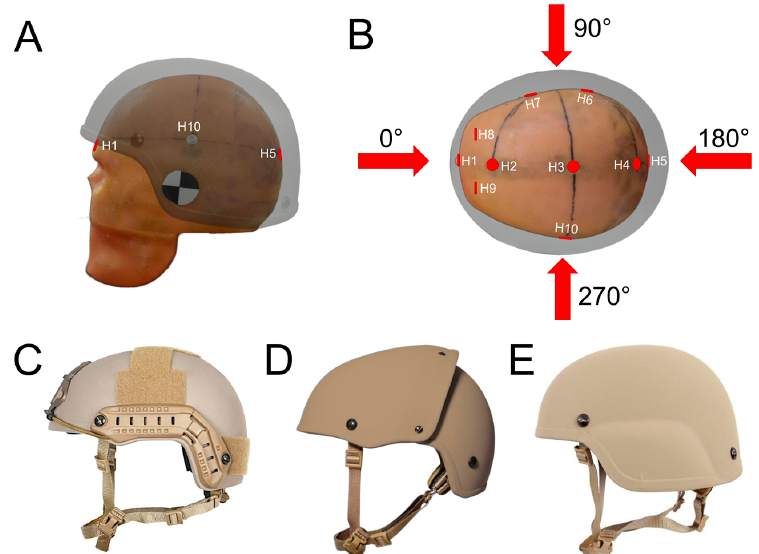
Figure 1. The schematic representation of the headform used in the ballistic helmet performance under blast loading experiments: ( A ) the headform with the outline of the Advanced Combat Helmet (ACH); ( B ) the top-view of the headform with the outline of the ACH illustrating the pressure sensor locations (denoted as H1 to H10) and the direction of the incident shock wave. Three types of helmets used in blast performance tests: ( C ) Ops-Core, ( D ) Airframe, and ( E ) Enhanced Combat Helmet (ECH).